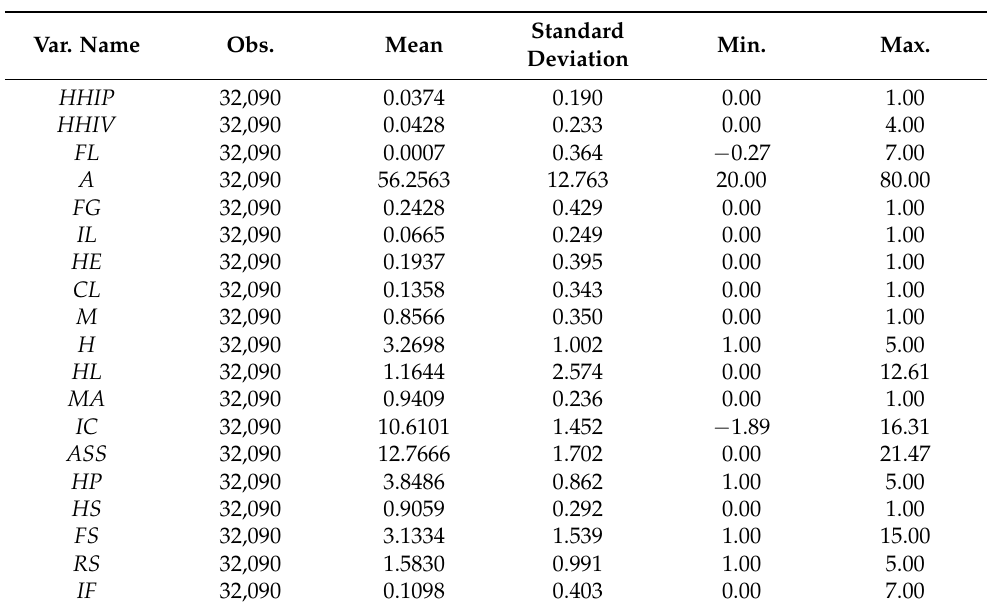
Table 4. Summary